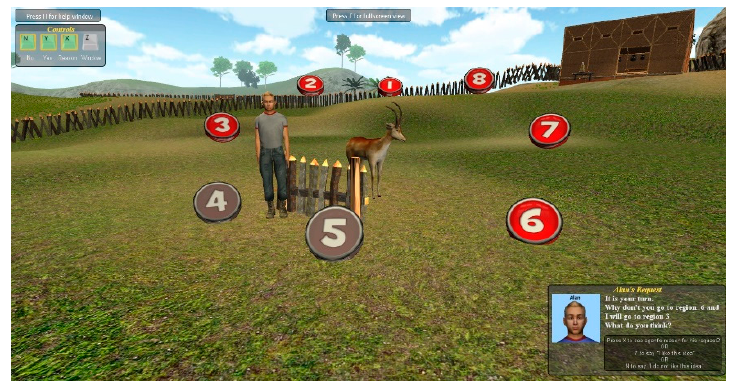
Figure 1. Screenshot from the scenario in Omosa Virtual World.